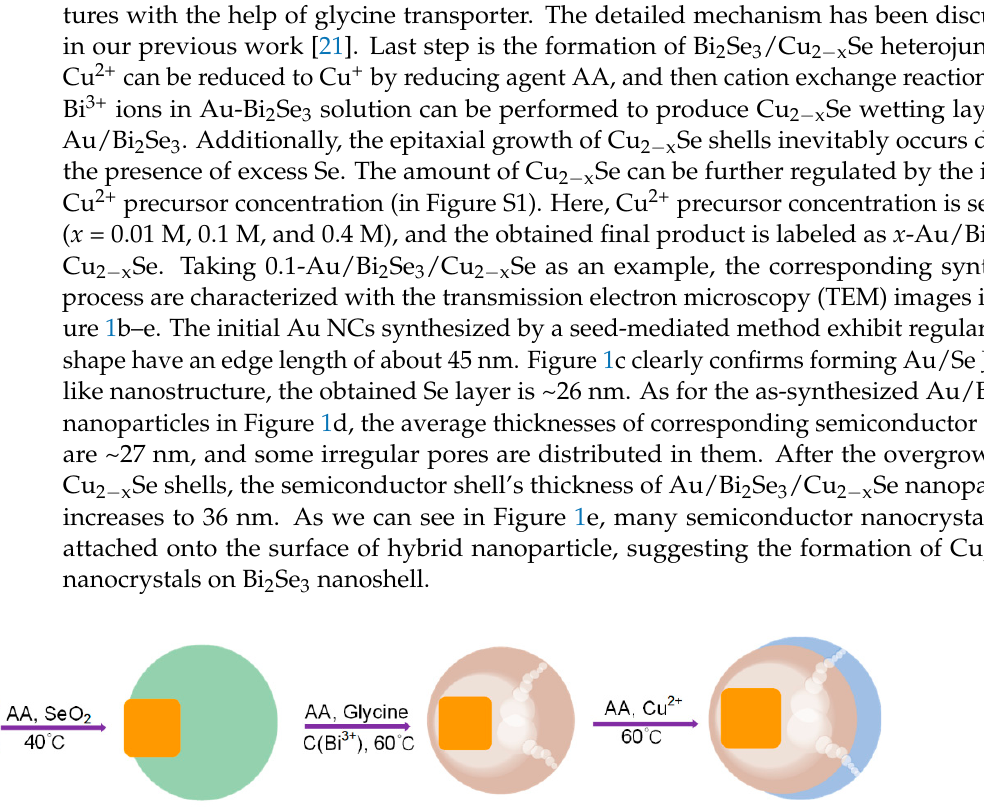
Figure 1a. Step one is the synthesis of the Au/Se Janus-like nanostructures. Using hexa-